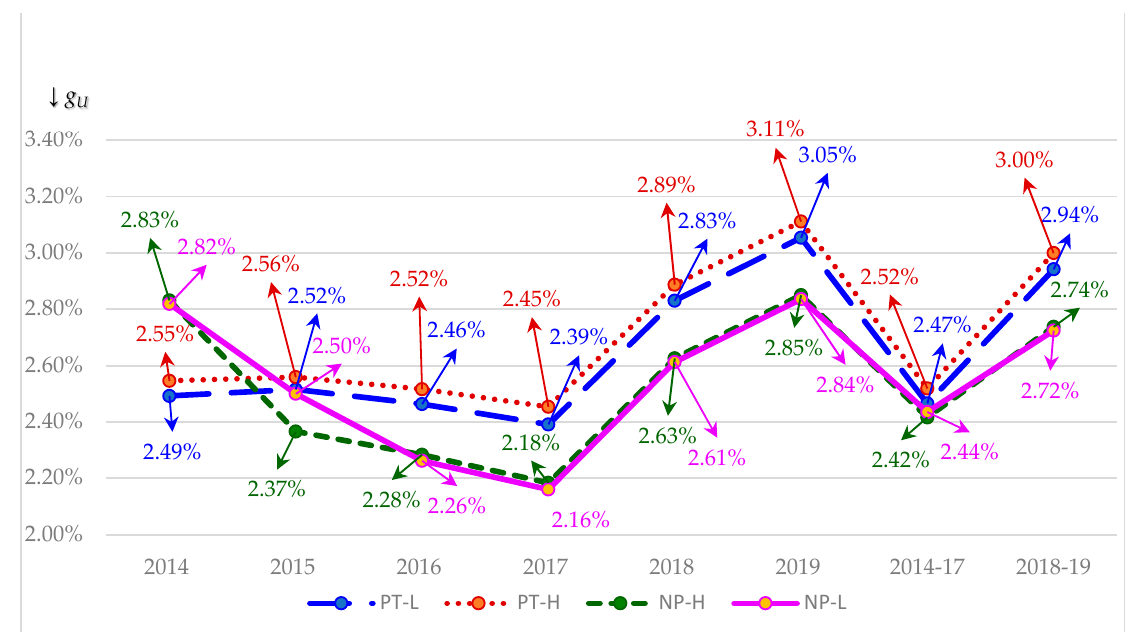
Figure 9. Unlevered equity growth rate ( g U ) values are plotted along the vertical axis against six years (where annual credit spreads are different) and two periods (where annual credit spreads are averaged) along the horizontal axis. The four trajectories are NP- L trajectory, solid line; NP- H trajectory, small dashed line; PT- L trajectory, large dashed line; and, PT- H trajectory, dotted line. We use pre-TCJA tax rates for 2014–17 with 3.12% growth rate and TCJA tax rates for 2018–2019 with 3.90% growth rate. Both the low ( L ) and high ( H ) tax rates are used where the growth ( RE ) constraint sets in after Ba1 for nonprofits (NPs) and after Ba2 for pass-throughs (PTs). As seen in Table 6, the optimal credit rating ( OCR ) varies over time with an OCR of A3 for the last two years of 2018 and 2019 for both NPs and PTs.